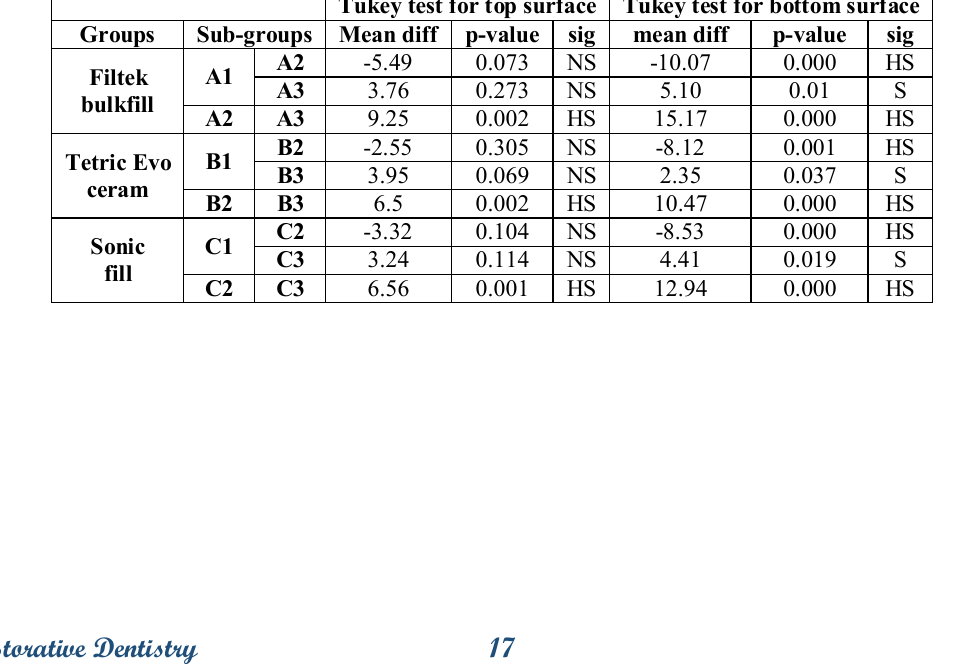
Table 6: Tukey test for the groups of tested materials for both top and bottom surfaces. Tukey test for top surface Tukey test for bottom